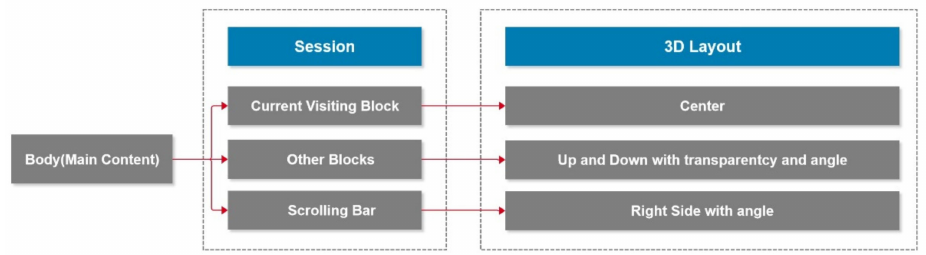
Figure 7. Structural concept of the main content [21].